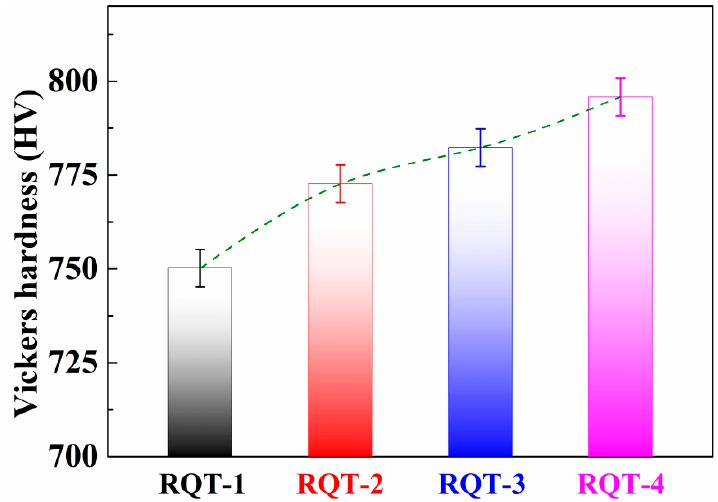
Figure 8. Vickers hardness of RQT specimens.